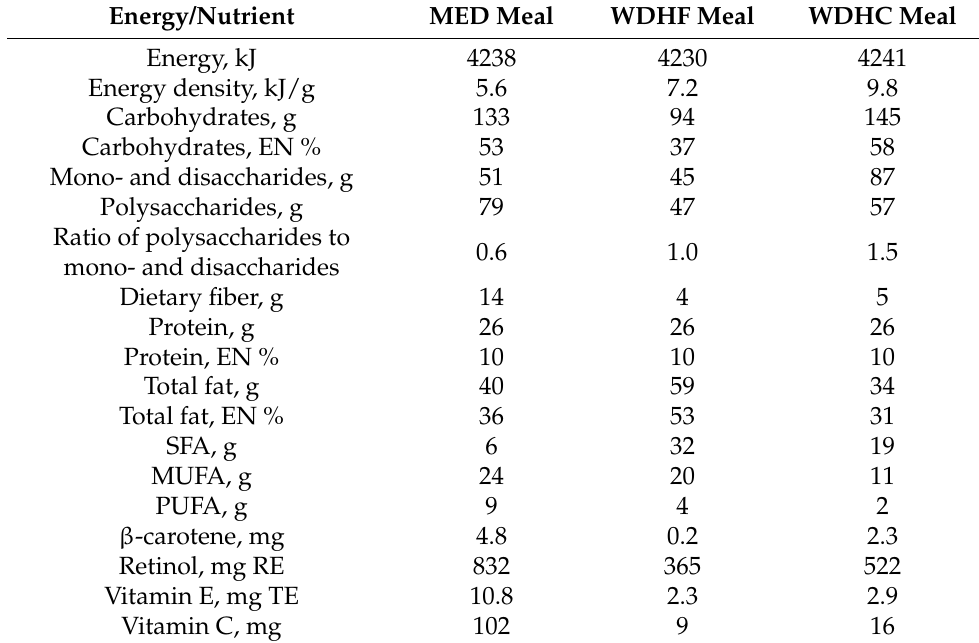
Table 1. Energy contents and nutrient compositions of the test meals (adapted from